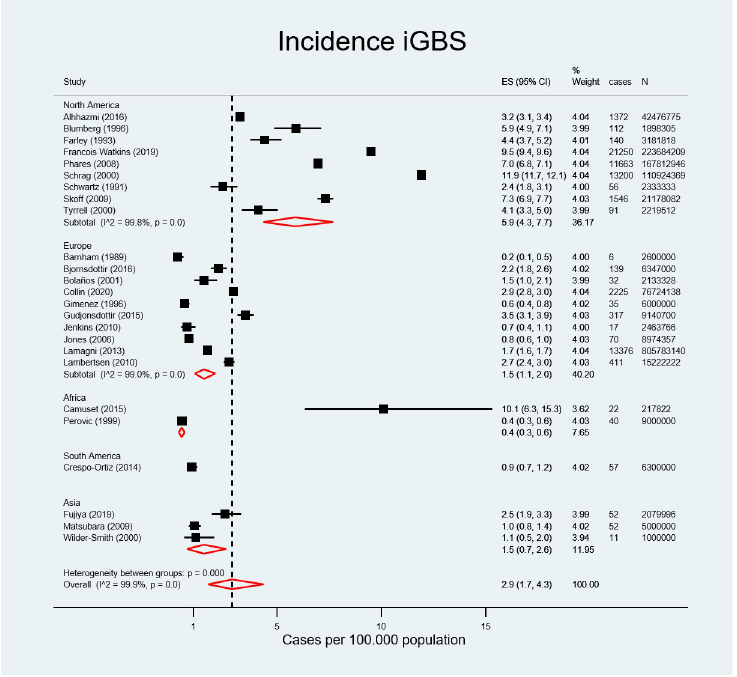
Fig 2. Pooled estimated incidence of invasive group B streptococcal infection by region.